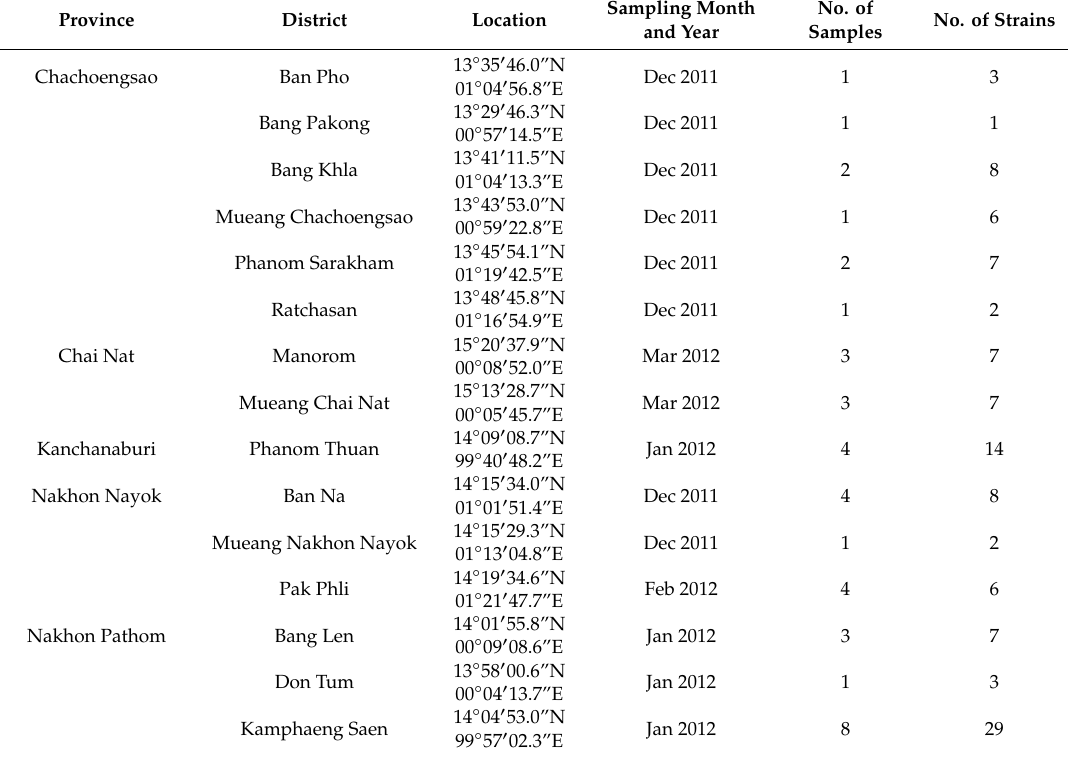
Table 1. Rice leaf samples collected in Thailand and the number of yeast strain isolated from the